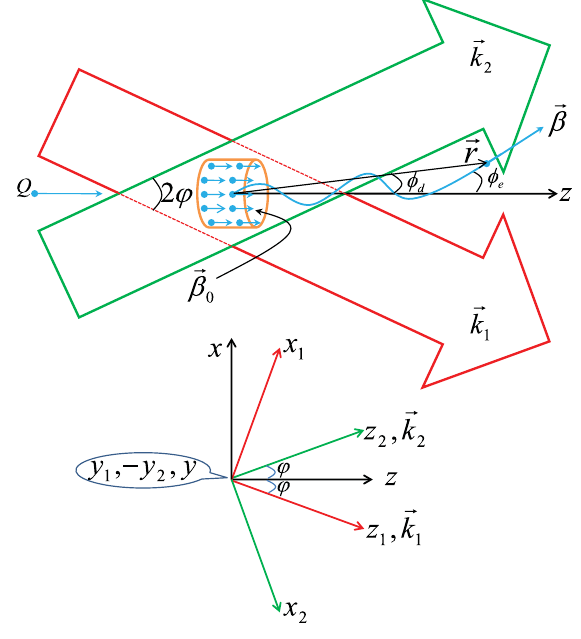
FIG. 1. A schematic of the charge Q injected midway between the two laser beams labeled by wave vectors k 1 and k 2 and crossing at the angle 2 ’ . Shown also is the initial ensemble of particles of initial scaled speed (cid:8) 0 , within a cylinder co-centered with the region common to both beams. Trajectory of a typical accelerated particle is shown. Ejection and deflection angles, (cid:9) e and (cid:9) d , represent directions of the (exit) vectors (cid:1) and r , respectively, relative to the coordinate z axis. The coordinate systems used to model the beams are shown in the lower part of the figure with y 1 and y pointing out, and y 2 directed into the